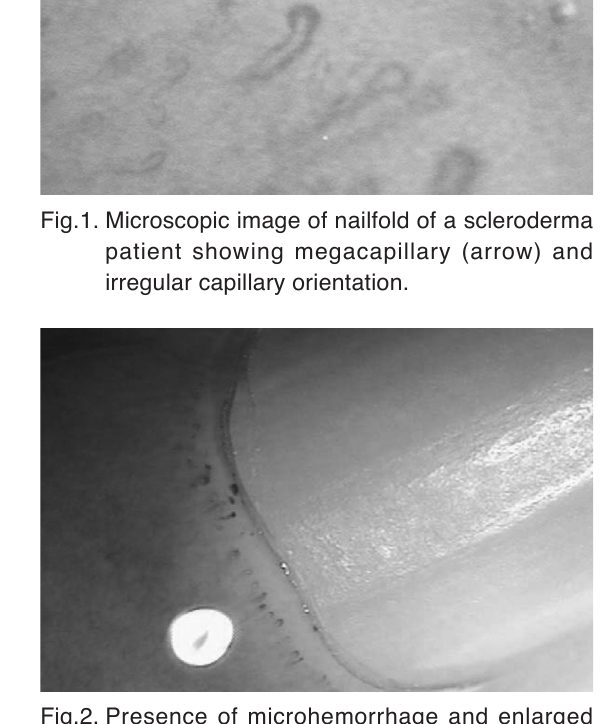
Fig.2. Presence of microhemorrhage and enlarged capillary loops visible in low-power fi eld (10X). An artificial light reflex is noted near the